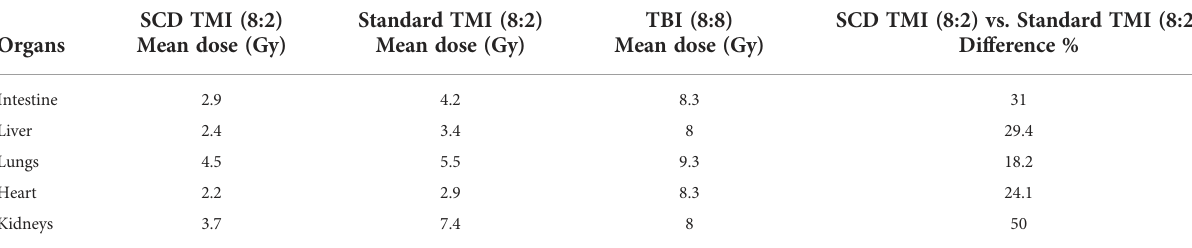
Kidneys The modi fi ed SCD plan reduces the mean doses on vital organs (liver: ~29%; lungs: ~18%; heart: ~24%; and kidney: ~50%) than the standard TMI (8:2) plan in B6 mice. TBI (8:8) delivers full prescription dose (~8 Gy) to all the